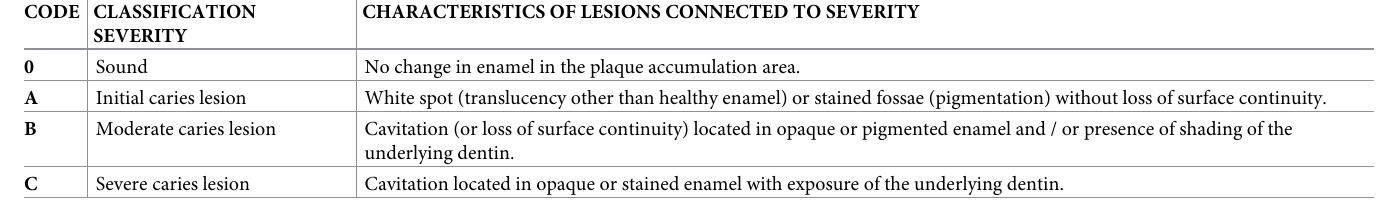
Table 1. Merged codes ICDAS TM .